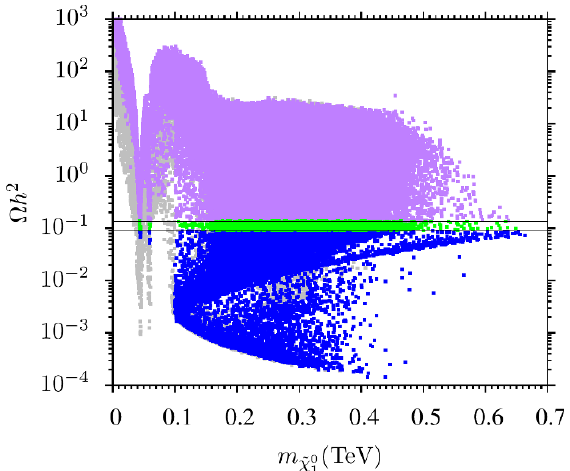
Figure 2 . Neutralino relic density (cid:10) (cid:31) h 2 vs. its mass, m . All points ful(cid:12)l (cid:1) EW (cid:20) 100. Grey e (cid:31) 0 1 points satisfy all the constraints discussed in section 3 except the LHC search and relic density constraints. Purple, green, and blue points are subsets of grey points representing solutions with relic density larger than, within, and lower than the range in eq. (3.14) respectively. These points also satisfy the LHC limits described in section